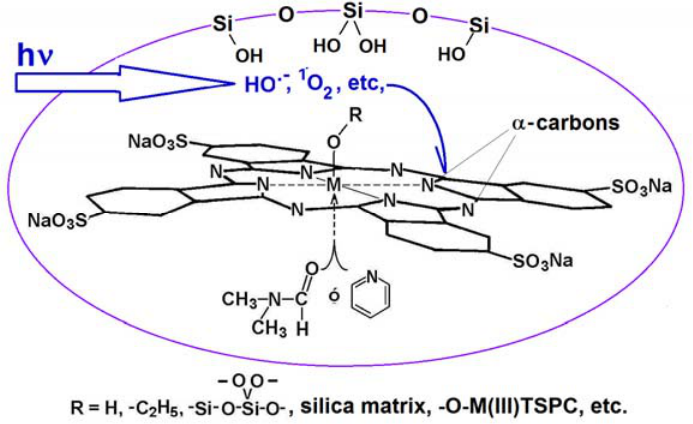
Figure 7. Hypothetical degradation mechanism of MTSPc species trapped inside the pores of silica through the photogeneration of radical